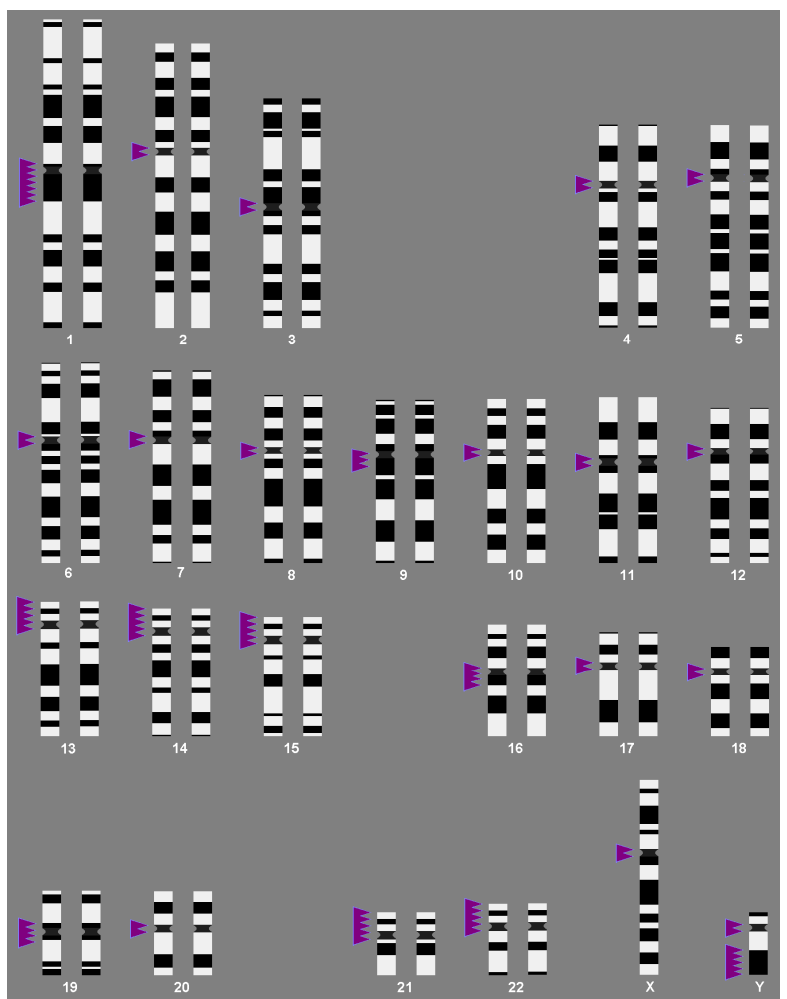
Figure 1. Ideograms of human chromosomes highlighting with arrowheads the regions of heterochromatic, cytogenetically visible copy number variations (CG-CNVs); see also Table 1. CHs are defined here as identical to heterochromatic CG-CNVs—best to be visualized in a cytogenetic preparation under a light microscope. However, during recent decades, research interest in banding and molecular cytogenetics (FISH) has decreased in parallel with the rise in molecular genetics [14]. In particular, human genetics is about to forget its two major roots in (i) genetic counselling [18] and (ii) the structure of chromosomes [19,20]. Therefore, it is easy to understand why CHs went out of the research focus. Even though CHs constitute at least 10% of the human genome [21], they became undetectable by application of a CMA and sequencing approaches. Both latter approaches are—due to technical reasons—entirely blind to human repetitive DNA [22] largely identical to CHs, and were lost to study given the saying: “Out of sight, out of mind”. Just recently, a paper demonstrated that the entire genome can be comprehensively sequenced [15], and this may be a landmark for new research on heterochromatic MG-CNVs and heterochromatic CG-CNVs. In Table 1, the available cytogenomic approaches are compared with respect to their abilities to access (potentially) heterochromatic DNA stretches (see also